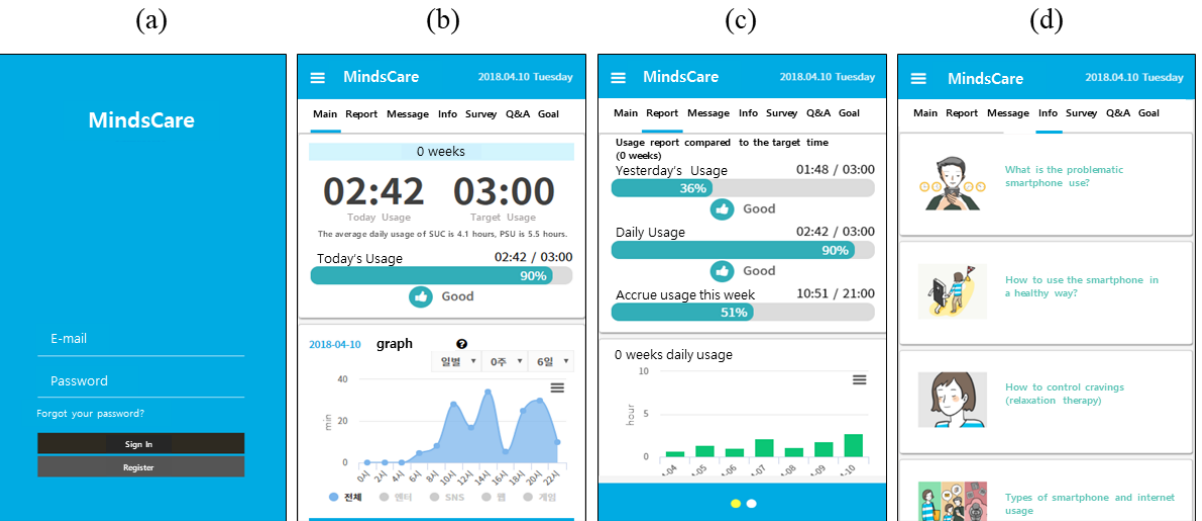
Figure 3. Screenshots of ‘MindsCare’ application. The features of MindsCare: ( a ) login page, ( b ) application’s main screen, representing usage time of the day, goal, and daily and weekly usage graphs, ( c ) a more detailed report about usage time compared to self-targeted goal, and daily and weekly usage, ( d ) information about problematic smartphone use and ways to reduce craving.